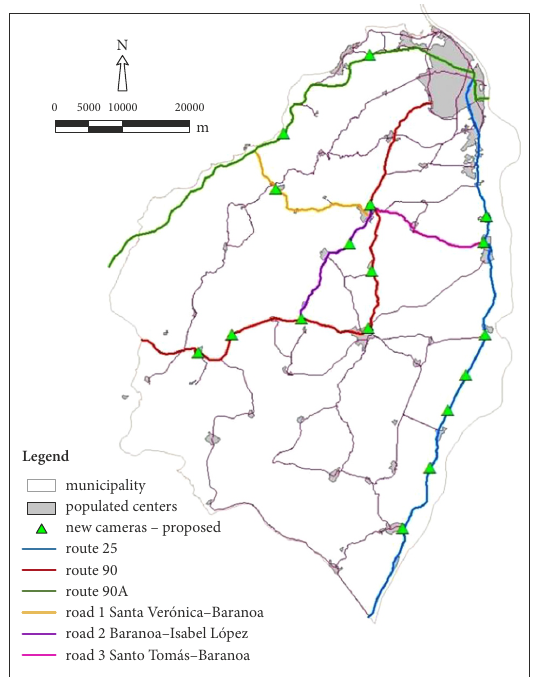
Figure 12. Risks, injuries and FWI areas with Z ≥ 1.96 Figure 13. Proposal for camera